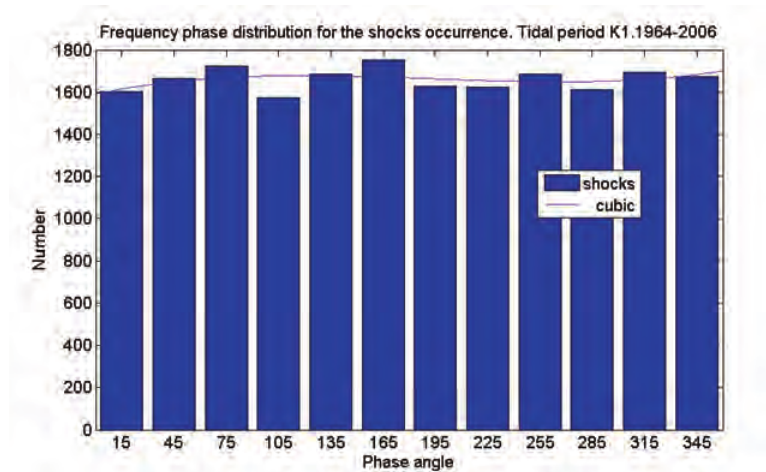
Figure 4. Cumulative histogram corresponding to the M2 period, of all of the 19.916 events.